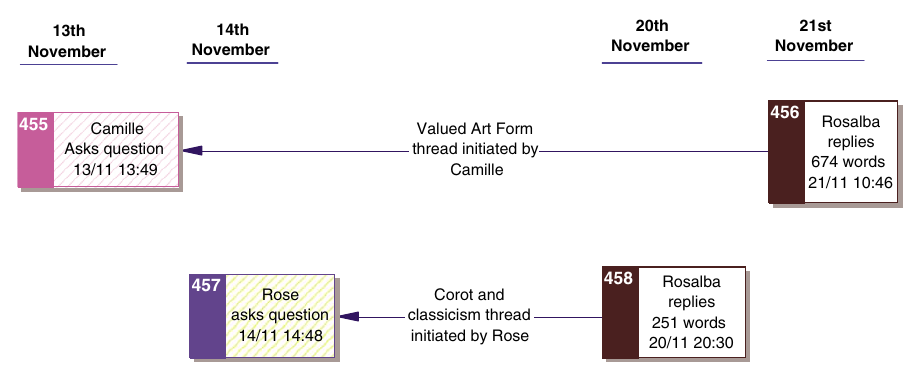
Figure 2. Visual timeline of Rosalba’s threads 2 and